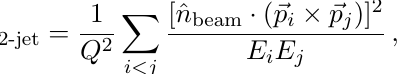
Figure 3 . The plot shows the di(cid:11)erence between the EVENT2 result for D 2 (cid:0) jet at NLO, i.e. O ( (cid:11) 2 and the expansion of the